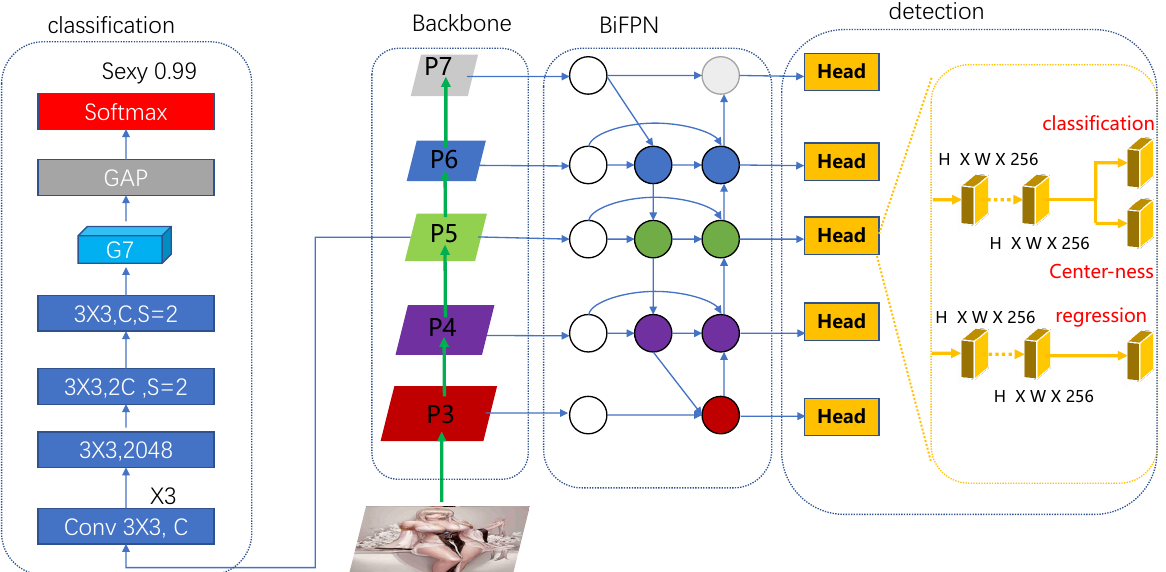
Figure 3. The DCNet architecture for porn image recognition. In DCNet, the bidirectional feature pyramid network (BiFPN) is used to achieve multi-scale feature fusion, while the classification network generates the recognition score of the video falling into any of the three categories: Normal, sexy, and porn. Besides, the detection branch is capable of capturing local information. Note that GAP denotes global average pooling and C is the channel of feature maps. In addition, S is the stride of convolutional kennel while H × W is the height and the width of feature